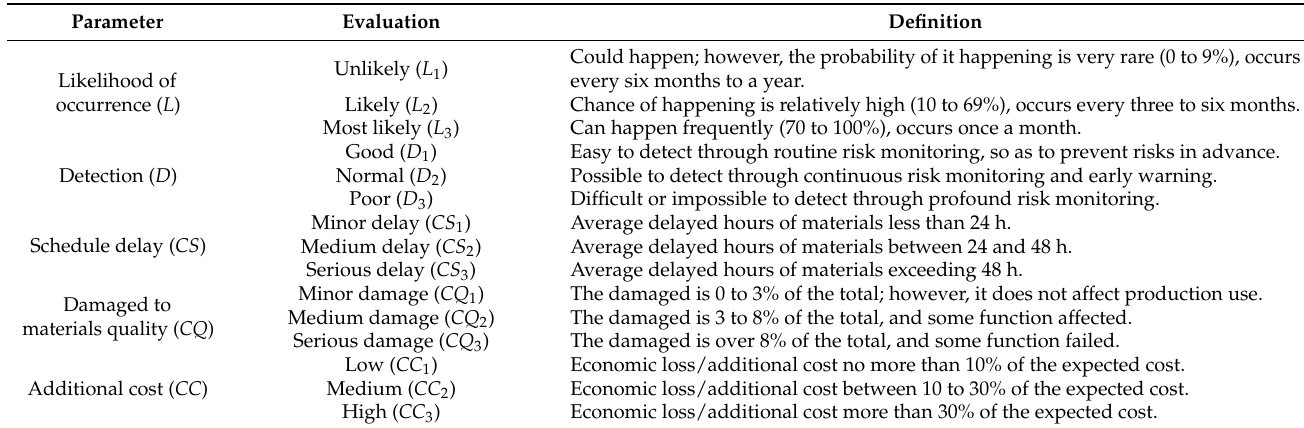
Table 2. Linguistic evaluation scale for the risk factors of five parameters.